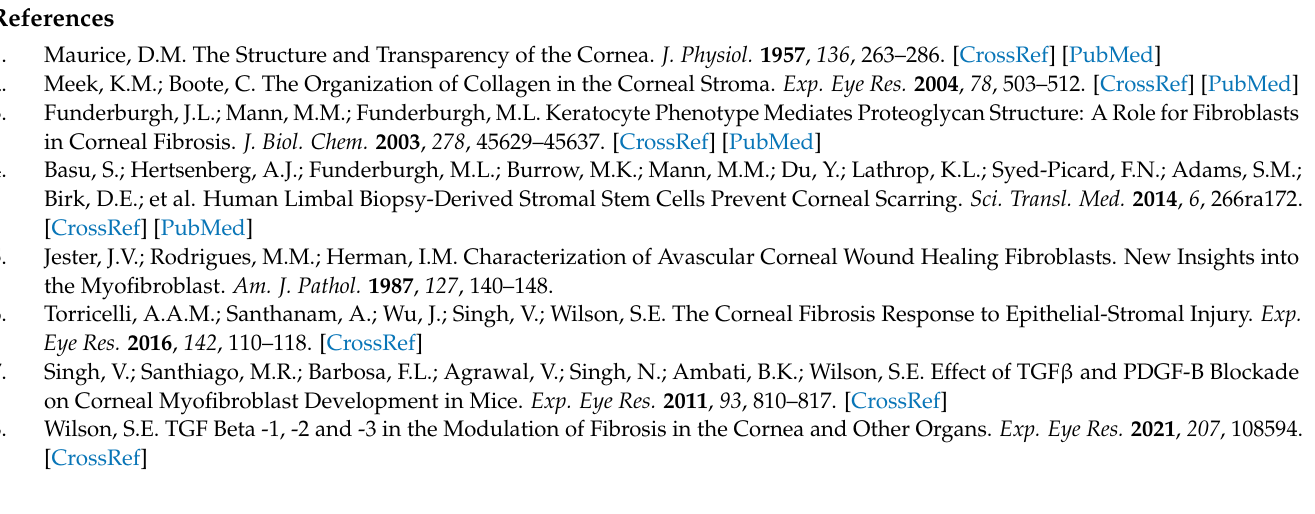
hLMSCs; Table S6: Rabbit clinical chemistry after En-/En+ hLMSC treatment; Table S7: Summary of histopathological observations of rabbit organs post-treatment with hLMSCs; Table S8: Organ